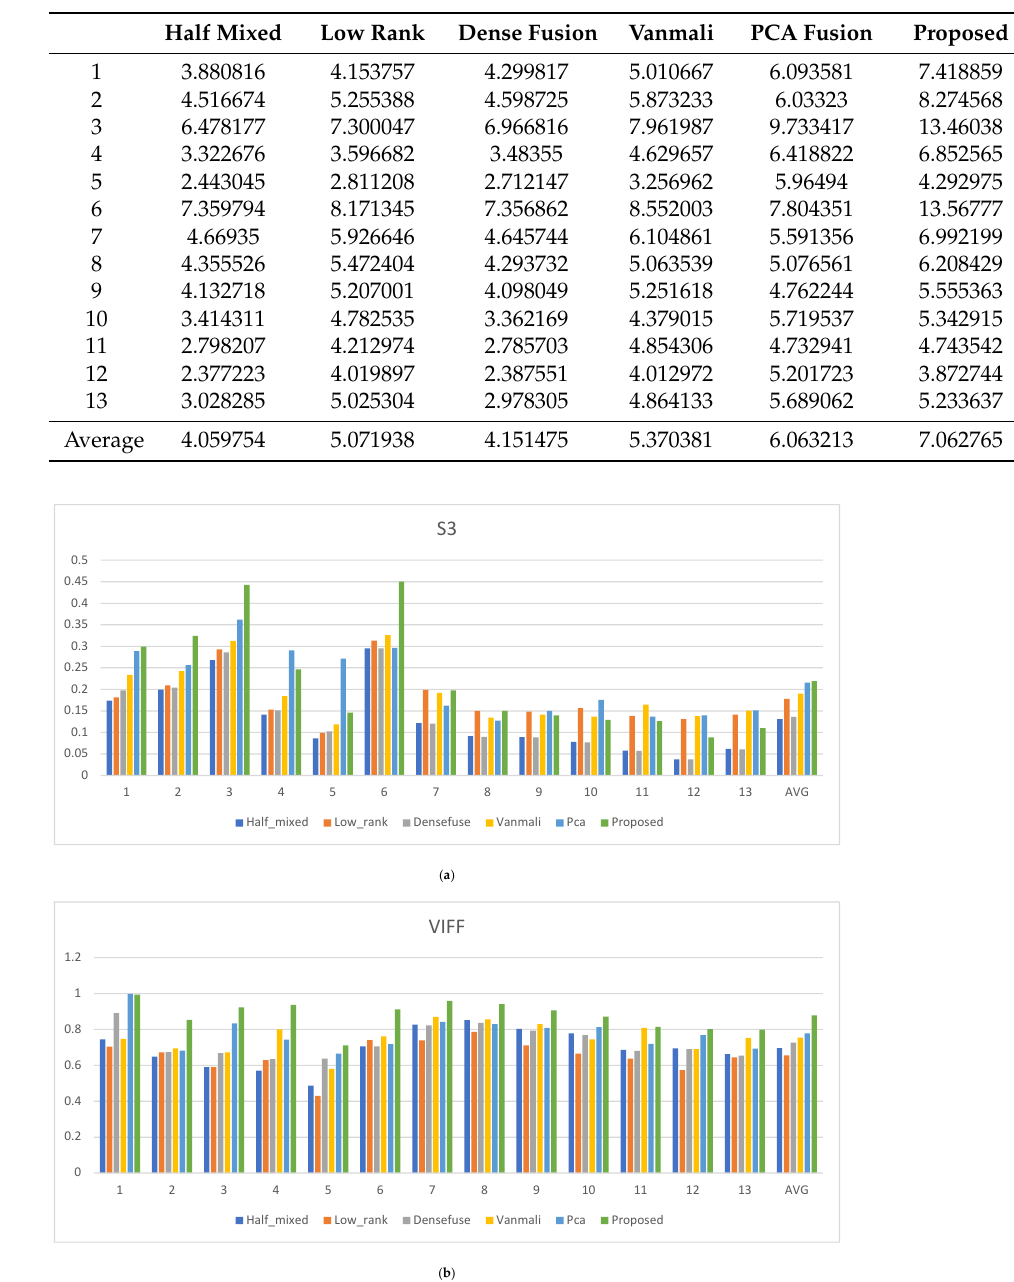
Figure 20. Metric scores: ( a ) S3 score; ( b ) VIFF score; ( c ) spatial frequency score ( d ) LPC SI score; ( e ) edge intensity score; ( f ) average gradient